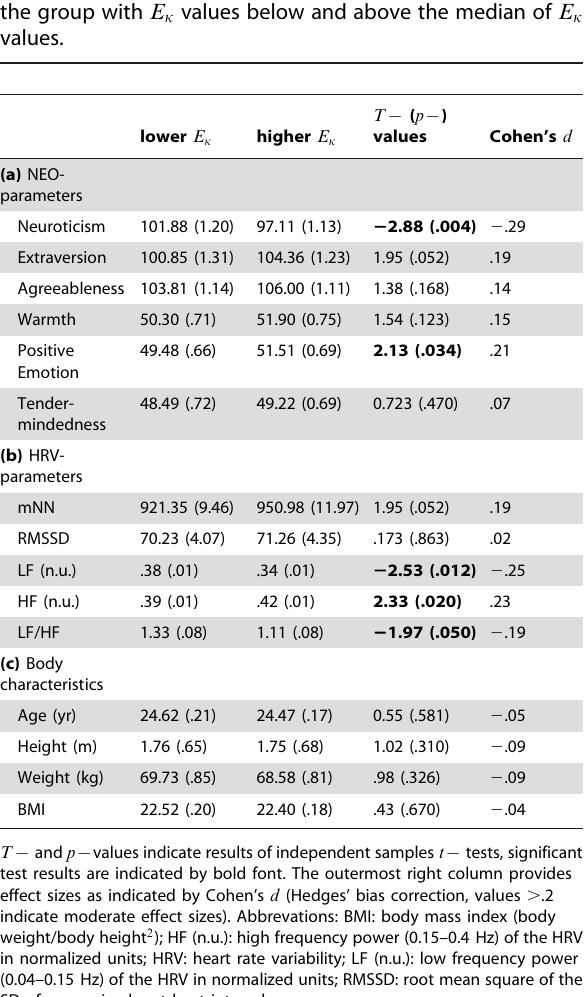
Table 1. NEO-scores, heart rate variability values, and body characteristics (means, with SD in parentheses), separately for the group with E k values below and above the median of E k values.